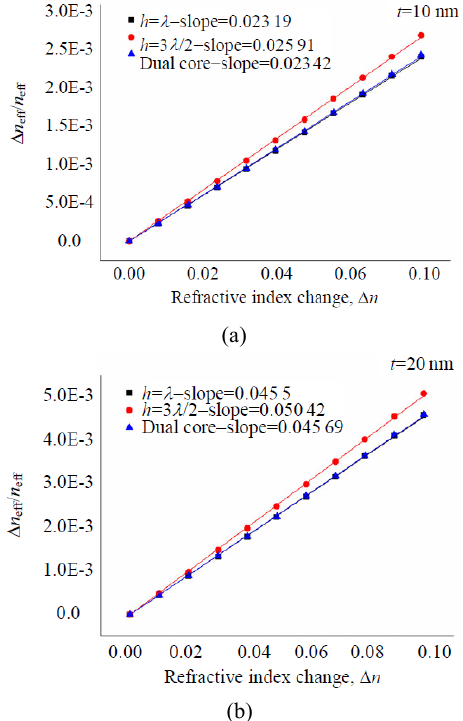
Fig. 8 Relative changes in the effective refractive index, and consequently in the resonant wavelength, as function of the refractive index change  n in the bio-layer, when its thickness is (a) t =10 nm and (b) t =20